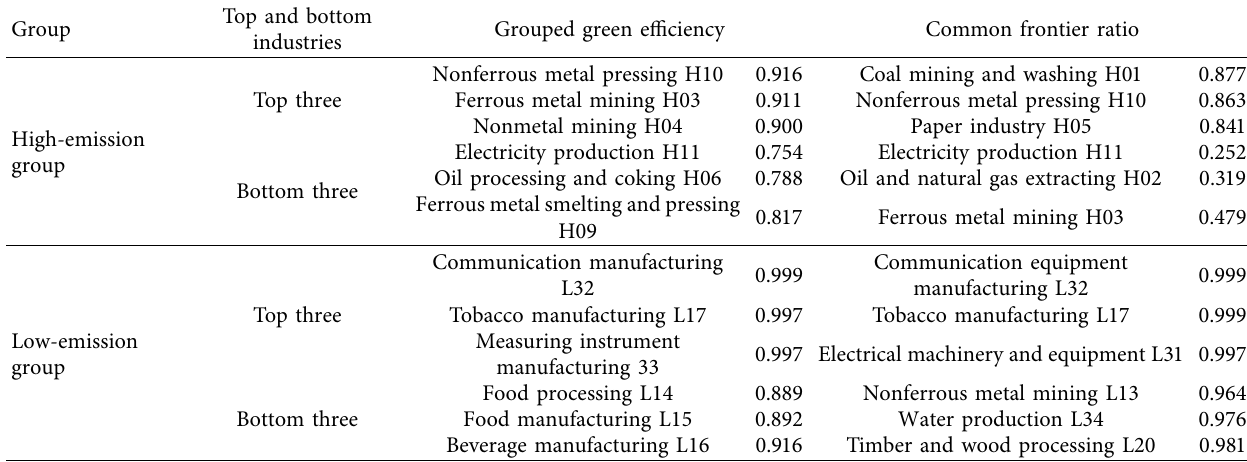
Table 6: Comparison between group green efficiency and metafrontier ratio.